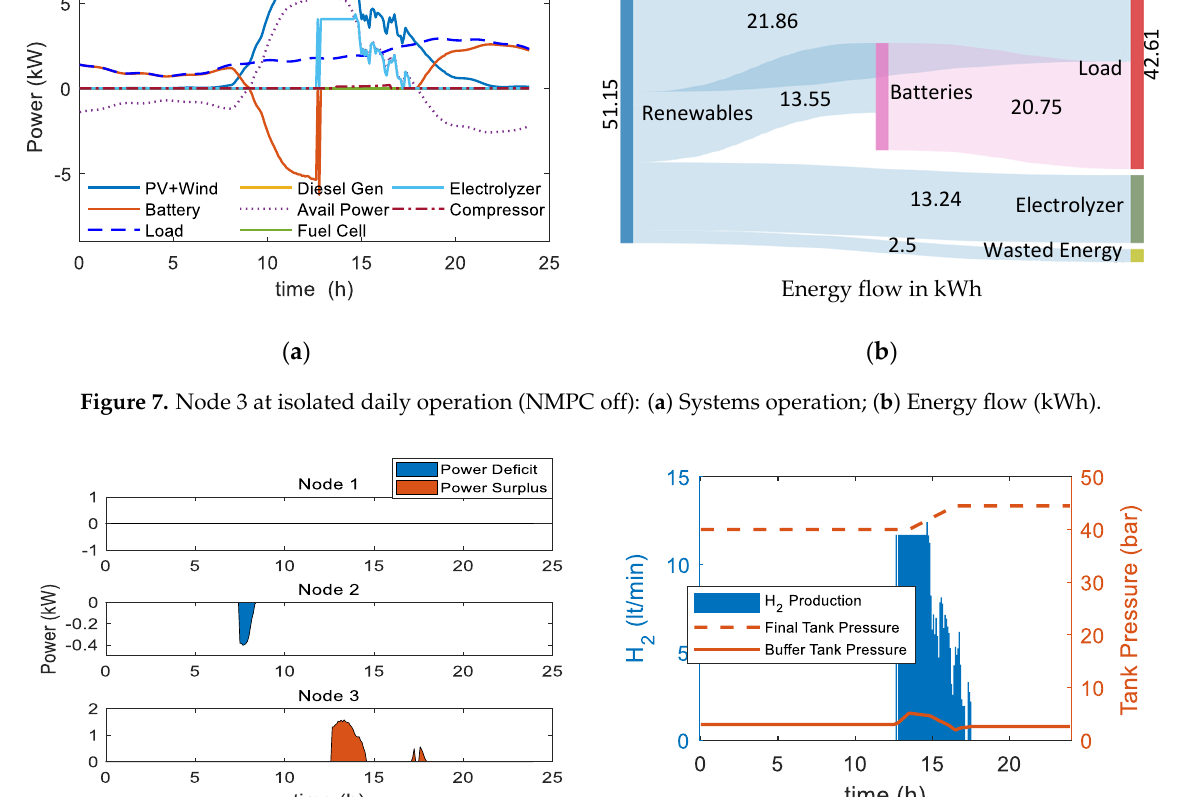
Figure 9. ( a ) Battery SOC at each node with NMPC enabled; ( b ) Control actions u applied at each time step at the DC/DC converters.